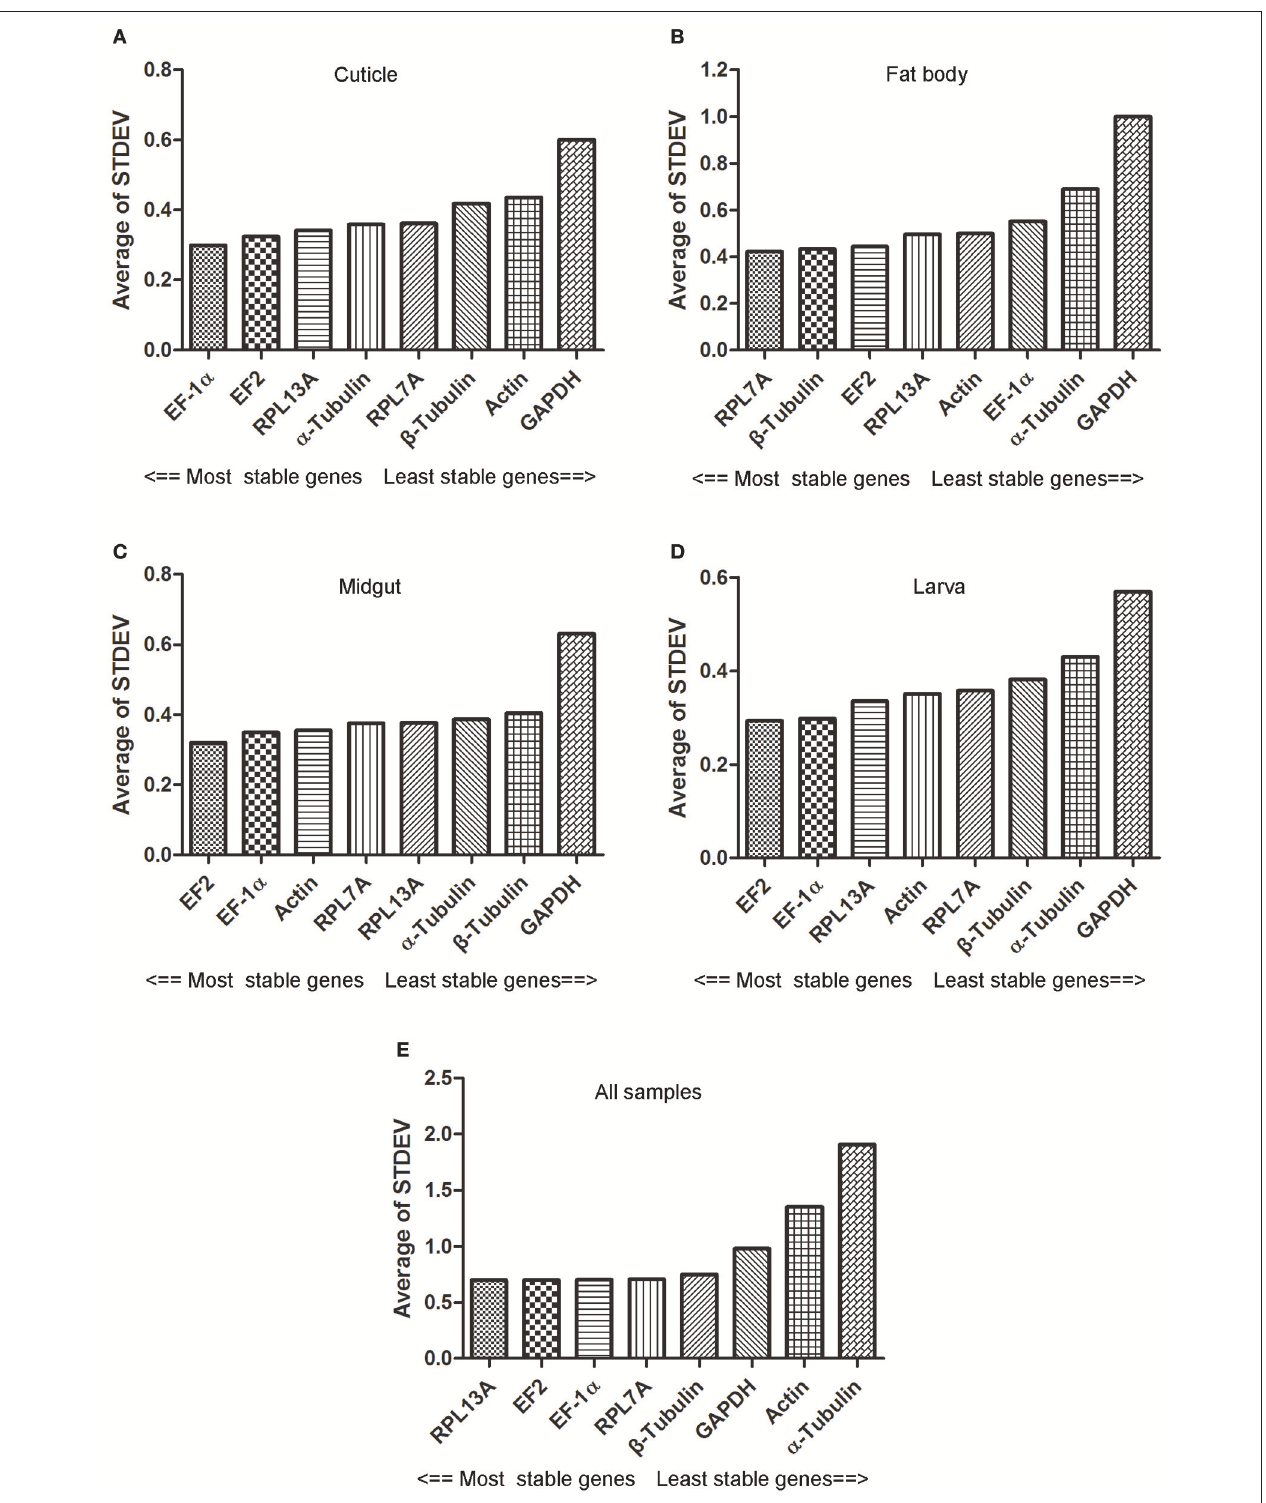
FIGURE 3 | Expression stability of eight candidate reference genes evaluated by Delta CT method. Abbreviations were showed as in Figure 1 . Panels (A–E) were represented as the stability validation results of reference genes expression in cuticle, fat body, midgut, larva, and all samples.